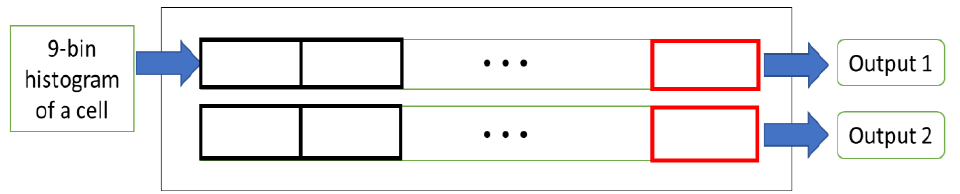
Figure 12. The block diagram of two-row histogram buffers.